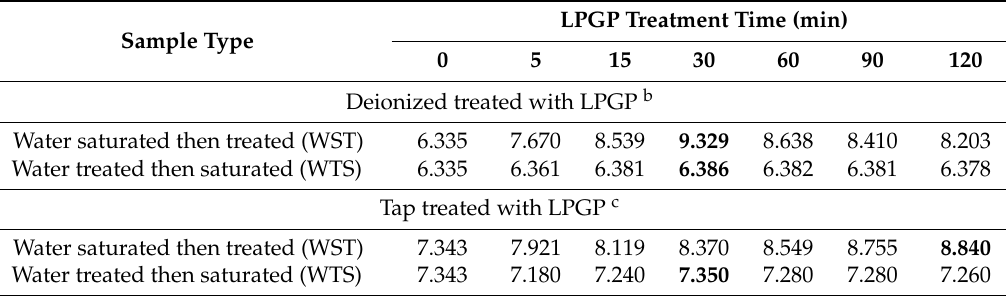
Table 1. pH values a of water treated under oxygen with LPGP.